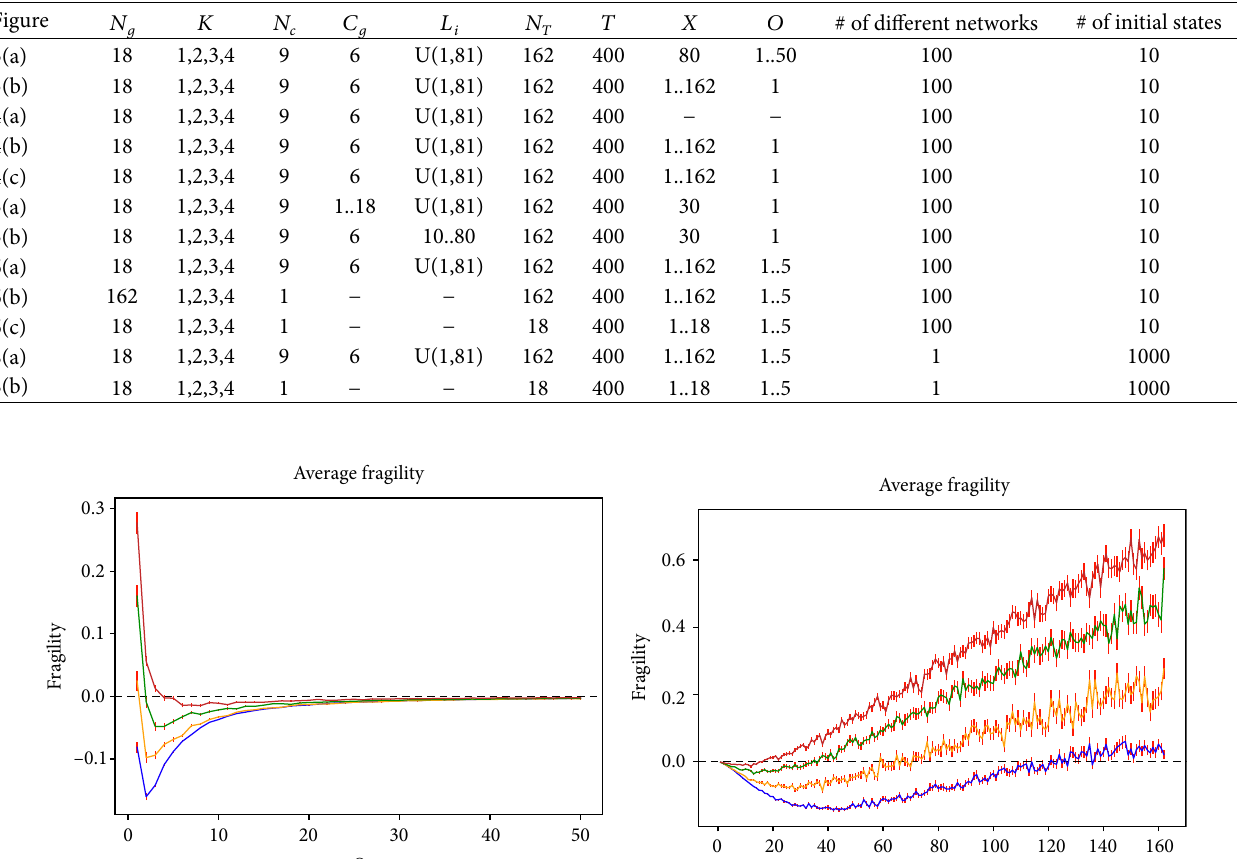
Table 1: Parameters for simulations and their values.